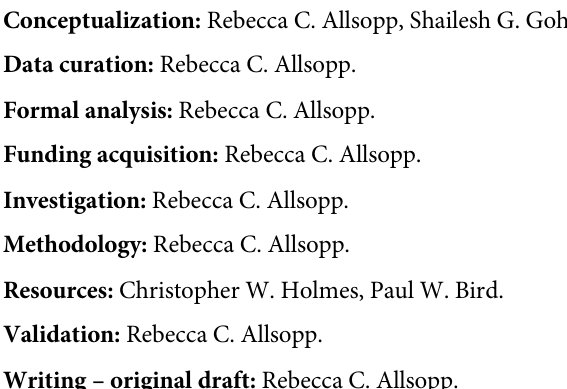
S1 Table. RT-LAMP primer sequences targeting the large open reading frame. ORF1a- HMSe designed by Rabe and Cepko 2020, and the nucleocapsid, envelope and human beta- actin gene designed by NEB (Tanner at al ., 2020 & Zhang 2020). S2 Table. Limit of detection of colorimetric end-point RT-LAMP reactions targeting geno- mic and sub-genomic regions of SARS-CoV-2. S3 Table. RT-LAMP TTP values (minutes) for fluorescent endpoint assays targeting the Orf1a and dual N+E gene regions against 114 UHL confirmed positive and 88 UHL con- firmed negative samples using the ABI StepOnePlus PCR platform. S4 Table. RT-LAMP TTP values (minutes) for fluorescent endpoint assays targeting the Orf1a and dual N+E gene regions against 38 UHL confirmed positive and 41 UHL con- firmed negative samples using the Qiagen Rotor-Gene Q platform. S5 Table. RT-LAMP TTP values (minutes) for colorimetric endpoint assays targeting the Orf1a and dual N+E gene regions against 21 UHL confirmed positive and 40 UHL con- firmed negative samples using the ABI StepOnePlus PCR platform. S6 Table. RT-LAMP TTP values (minutes) for colorimetric endpoint triple target (Orf1a/ N/E) assay against 41 UHL confirmed positive and 40 UHL confirmed negative samples using the ABI StepOnePlus PCR